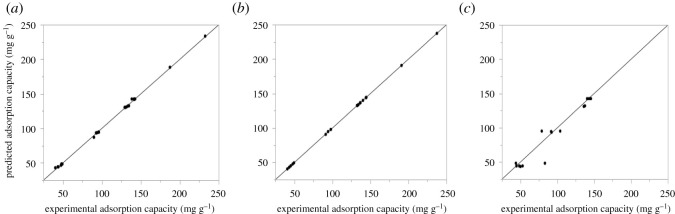
Experimental and Predicted ANN scatter plots (a) training, (b) testing and (c) validation.